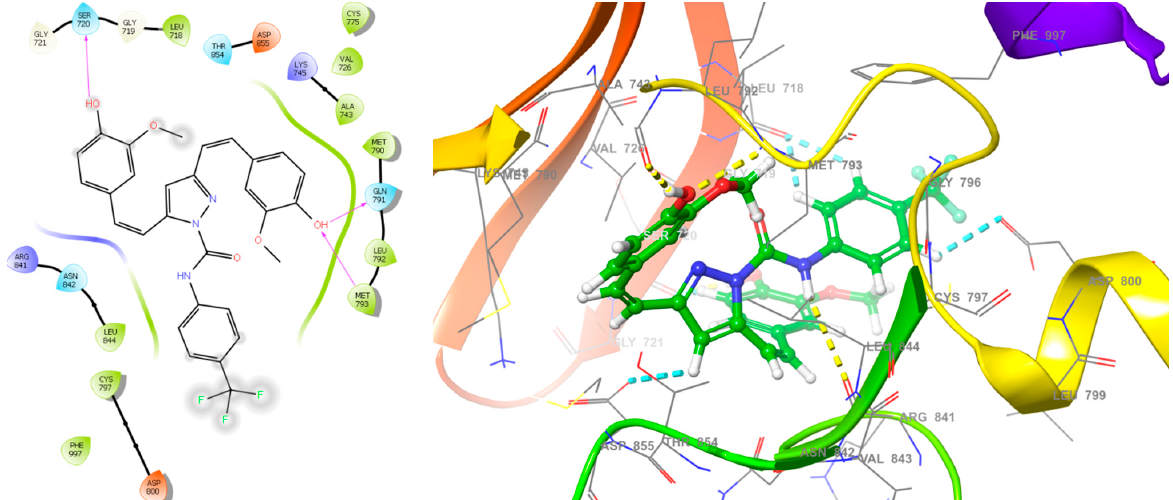
Figure 4. The 2D and 3D interactions of ligand 3c within the active site of